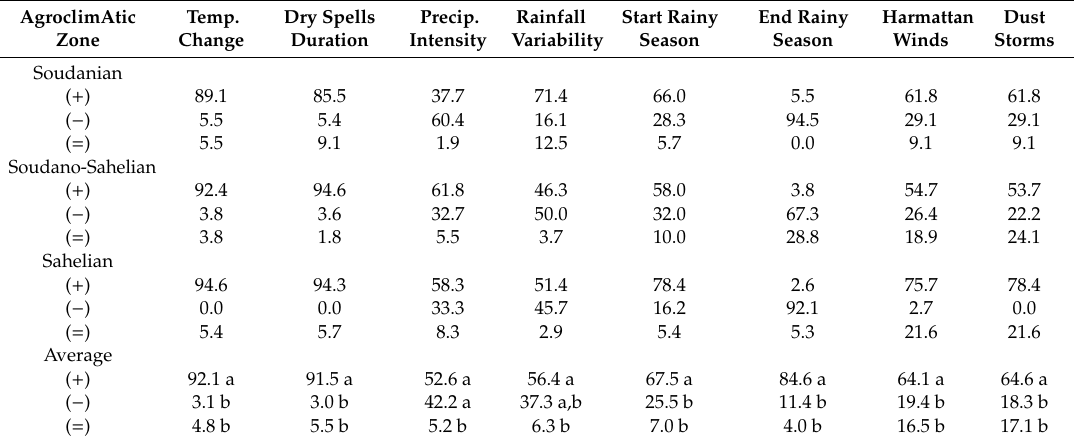
Table 7. Farmers’ awareness of changes on weather-related hazards in the di ff erent agroclimatic zones (Soudanian, Soudano-Sahelian, and